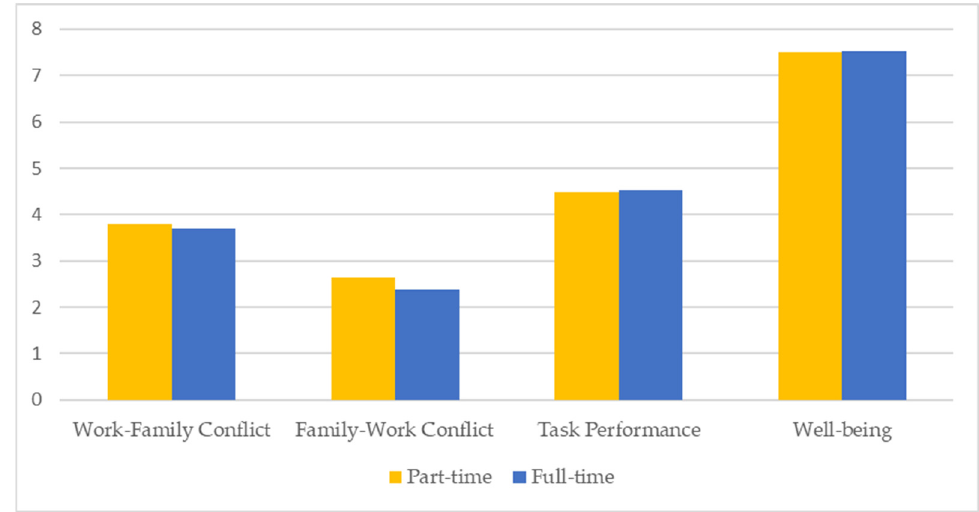
Figure 10. Distribution of variables by type of work regime (part-time or full-time).